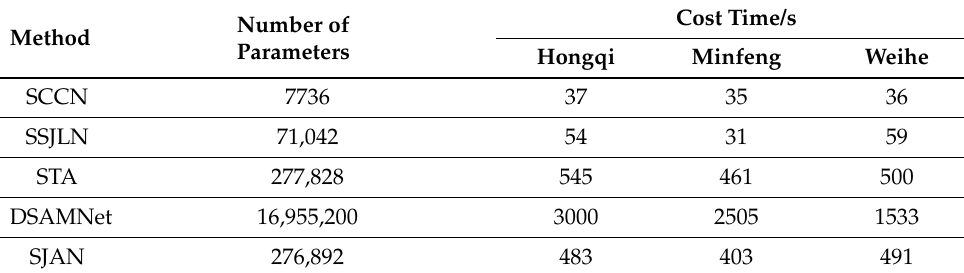
Table 2. Comparison of training time and number of parameters. Number of Method Parameters